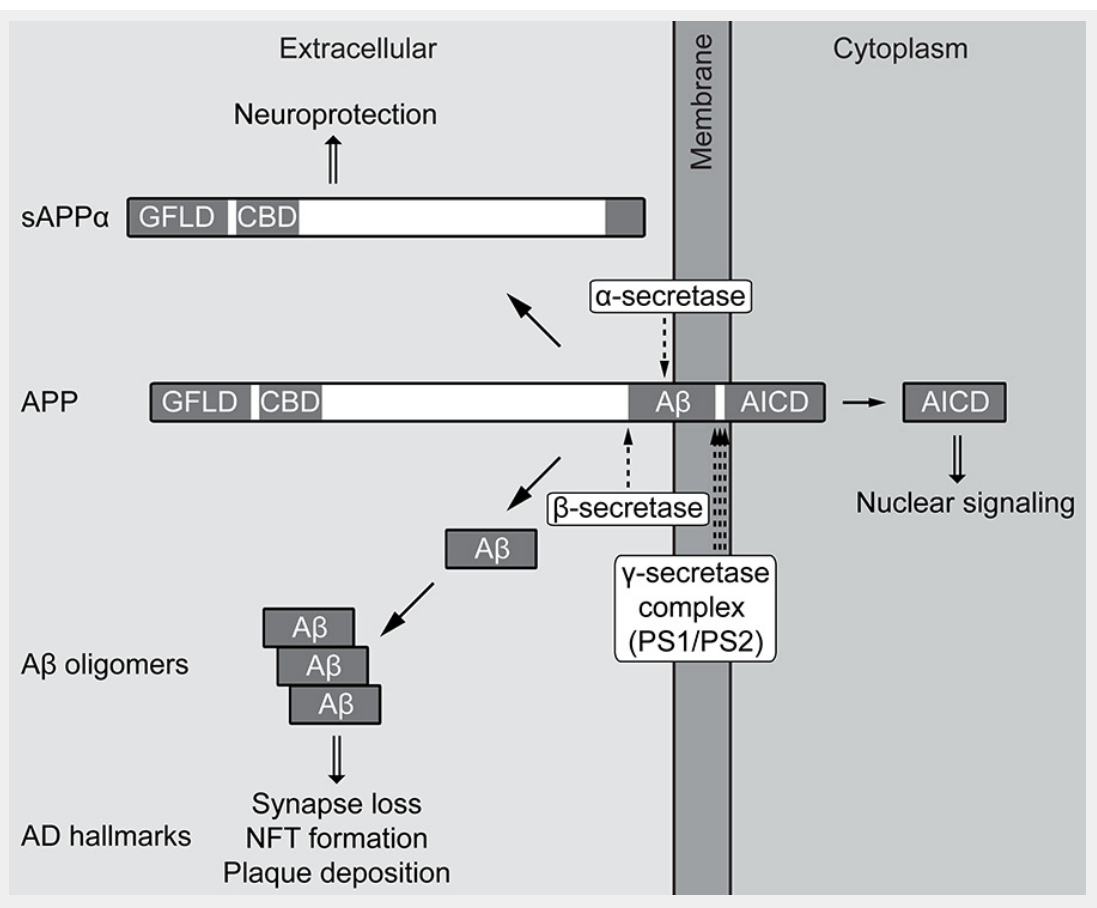
Proteolytic processing of the amyloid precursor protein (APP). APP is a single-pass transmembrane protein with a large extracellular domain and the short APP intracellular domain (AICD) facing the cytoplasm. Sequential proteolytic cleavage by the secretases occurs via two opposing pathways, both initiated by the release of the extracellular domain. Non-amyloidogenic cleavage by α-secretase destroys the Aβ peptide and releases secreted APPα (sAPPα). This APP fragment contains a growth factor-like domain (GFLD) and a copper-binding domain (CBD) and displays neuroprotective and neuroproliferative properties. In the amyloidogenic pathway, cleavage by β-secretase generates the Aβ N-terminus and sAPPβ, which lacks the properties of sAPPα. After release of the extracellular domain, the remaining APP transmembrane C-terminal fragments (CTFs) can enter the γ-secretase complex to undergo regulated intramembrane proteolysis (RIP), which consists of consecutive cleavages denoted by three arrows. This initially releases AICD from the membrane, which in the case of the amyloidogenic pathway can signal to the nucleus. In the same pathway, further cleavages by γ-secretase shape the Aβ C-terminus that is critical for determining aggregation propensity. Aβ aggregates into different oligomeric species that can induce synapse loss and neurofibrillary tangle (NFT) formation. Finally, Aβ deposits in large extracellular structures known as amyloid plaques – besides NFTs, a hallmark of Alzheimer’s disease